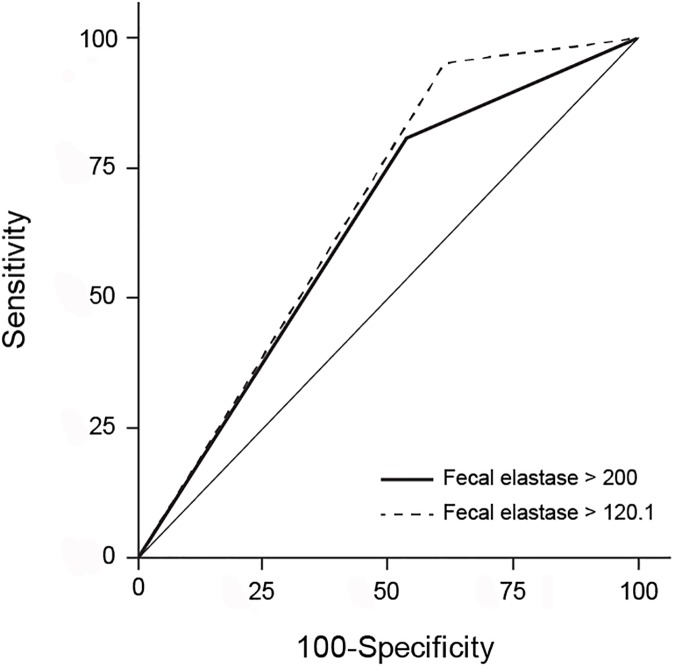
ROC curve for the comparison of the fecal elastase-1 levels at the cut-off points of 120.1μg/g stool and 200 μg/g stool.